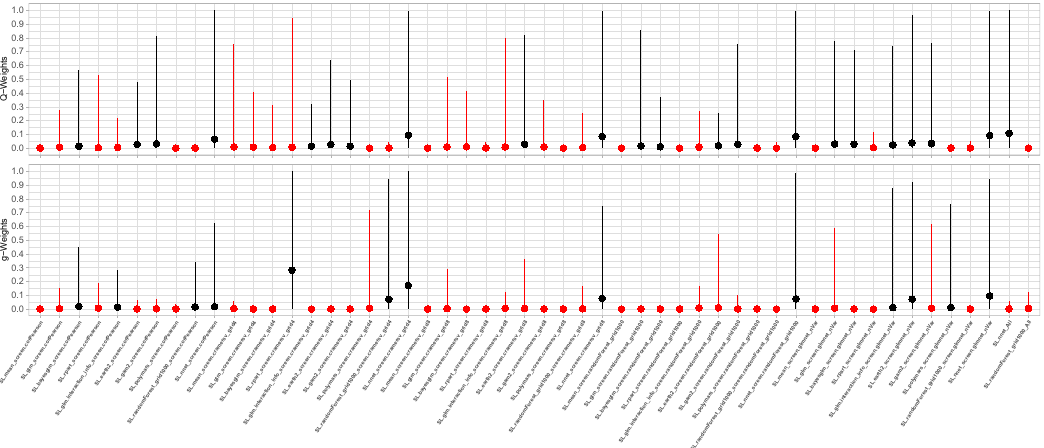
Figure 4: Distribution of learner weights. The visualized distributions are based on the merged learner weights that resulted from the estimation of Ψ 1,3 and Ψ 2,3 ( d d ¯ , ¯ t t 1 2 ∗ ∗ , and twice d ¯ t 3 ∗ ) , summarized across the imputed data sets. The plotted point represents the mean of each distribution. If it is below 0.01, both the distribution and the mean are displayed in red.